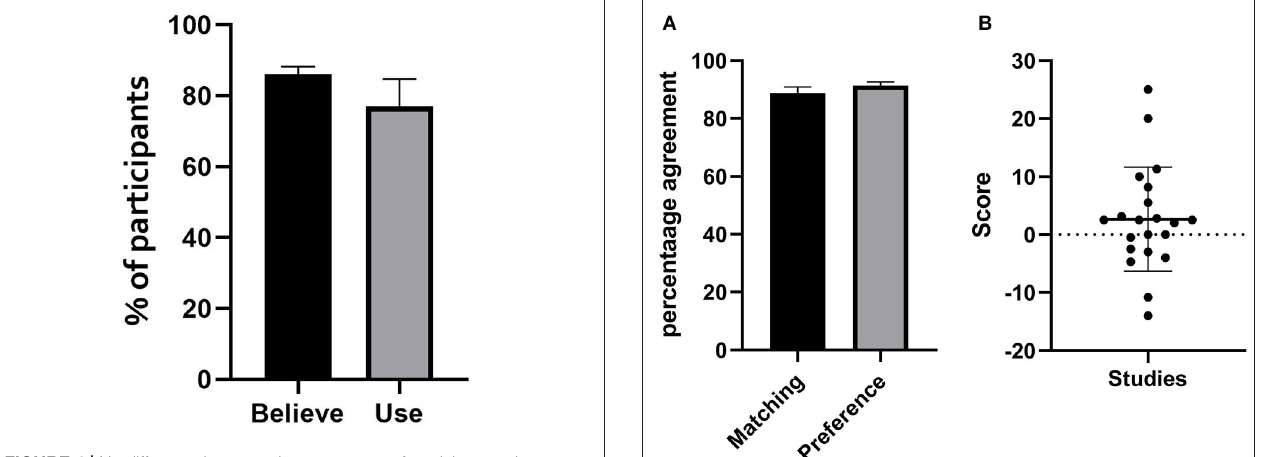
FIGURE 4 | No difference between the percentage of participants who report believing in the efficacy of matching instruction to Learning Styles, and the percentage who used, or intended to use, Learning Styles in this way. The pooled weighted percentage was 89.1 vs. 79.7%. P = 0.146 by Mann-Whitney U test.